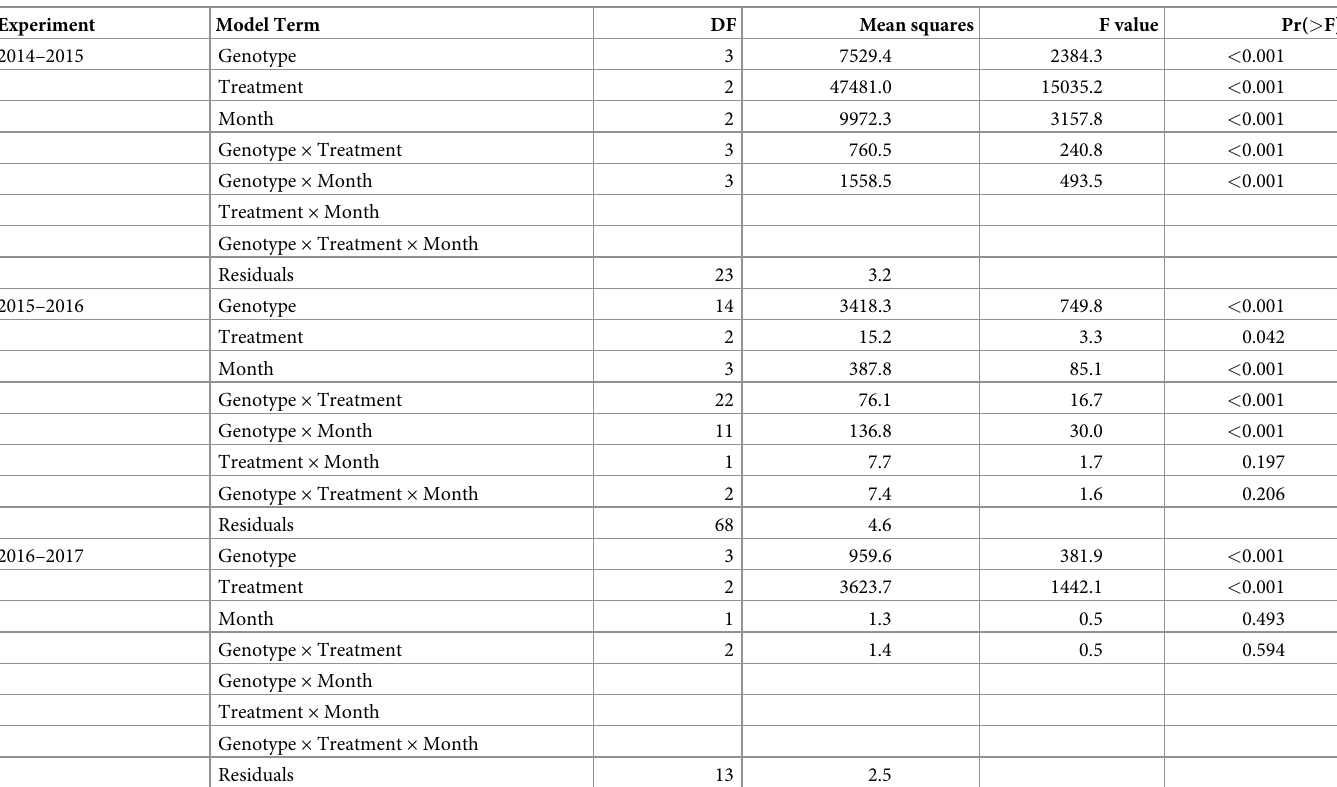
Table 5. Effects of treatments on days to first flowering for Miscanthus in a series of greenhouse experiments conducted in Urbana, IL over three years.